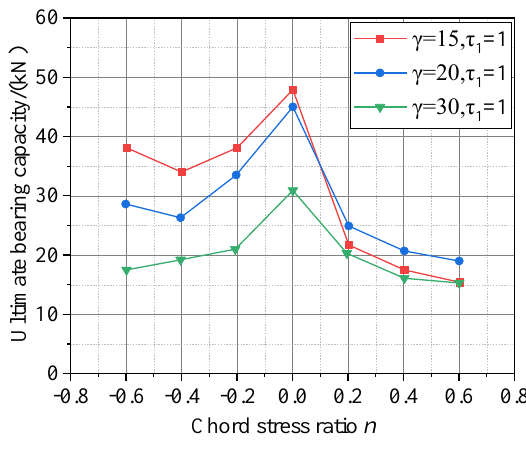
Figure 25. Effect of n .